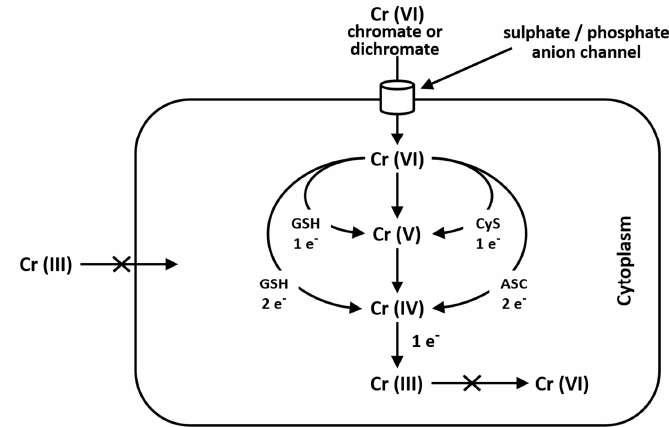
Figure 1. Pathway of chromium metabolism in the cell. Cr(III) is unable to cross the cellular membrane, while Cr(VI), being structurally similar to phosphate and sulfate, crosses the cellular membrane via a nonspecific anion channel. In the cell, Cr(VI) undergoes metabolic reduction to Cr(III) in the presence of Asc, GSH and Cys [38,41].